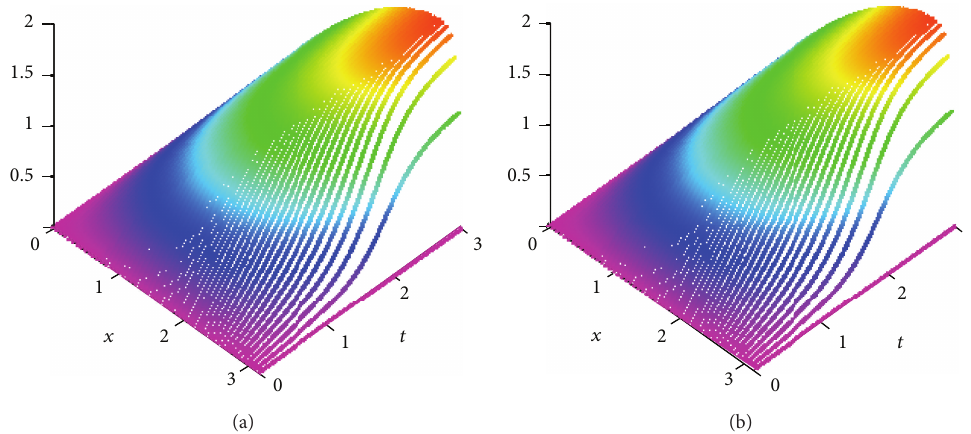
Figure 6: The space-time graph of the estimated solution of Burgers’ equation by using IMQQI (a) and DMQQI (b) for 𝜐 = 0.1 , 𝑥 ∈ [0, 𝜋] and 𝑡 ∈ [0,3] of Experiment 5.